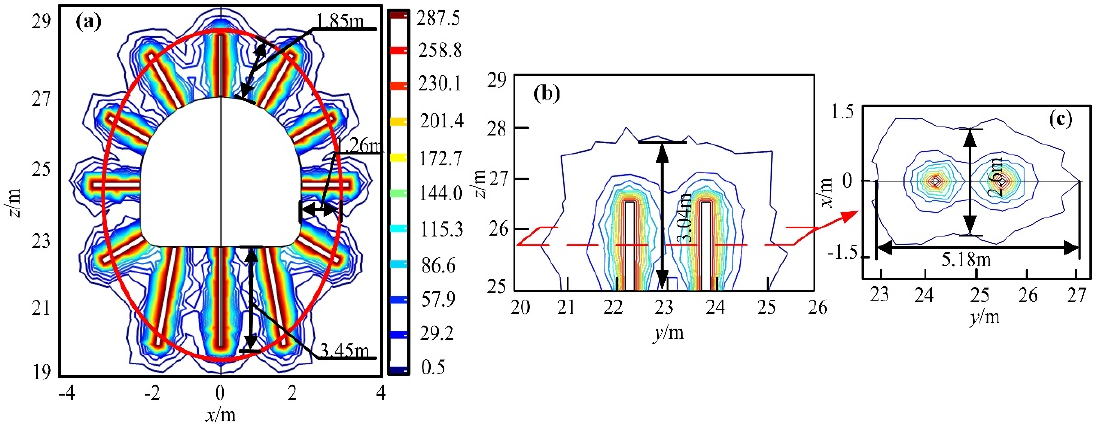
Figure 13. Gout diffusion effect within surrounding rock after grouting. ( a ) Cross section ( xz plane) of roadway; ( b ) vertical section ( yz plane) of roadway; ( c ) vertical section ( yx plane) of roadway.